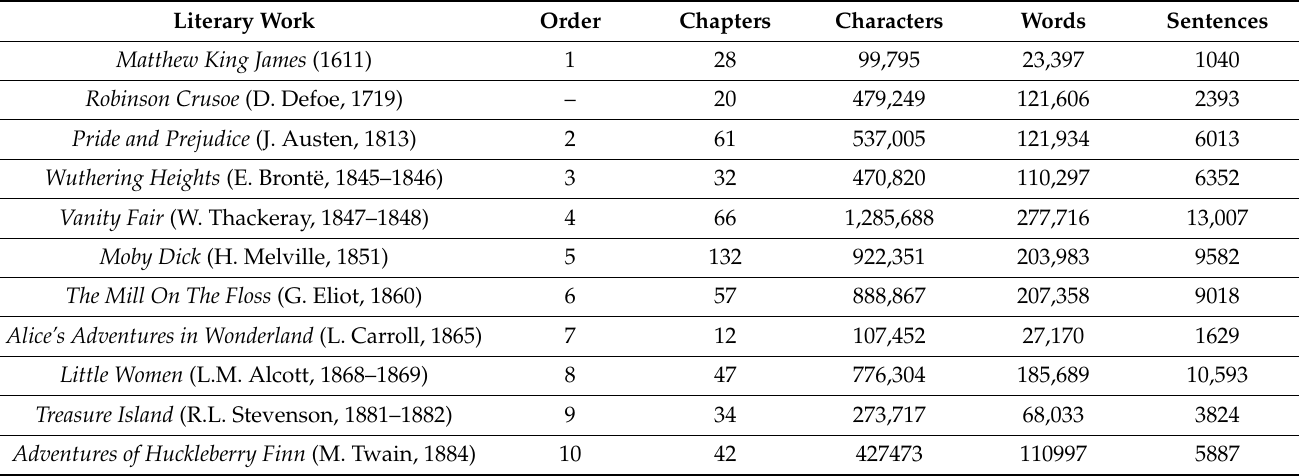
Table 2. English literature. Literary works are ordered according to publication years. Number of chapters (i.e., the number of samples considered in calculating the regression lines of the theory), total number of characters related only to words, total number of words and sentences. The order number is useful to identify the single literary works in Figure